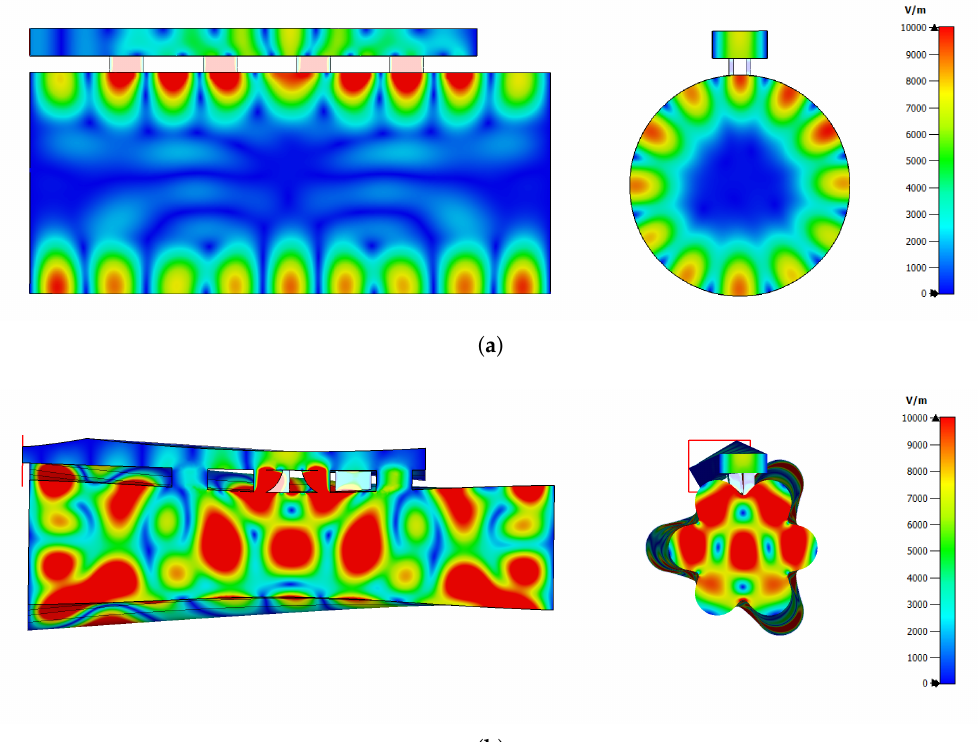
Figure 10. Electric field module plot on side and front slices for: ( a ) cylindrical cavity ( f 0 = 14.388 GHz) and ( b ) “plasma- shaped” cavity ( f 0 = 14.466 GHz) employing the side-coupled slotted waveguide injection system. Electric field has been normalized to the maximum value of 10